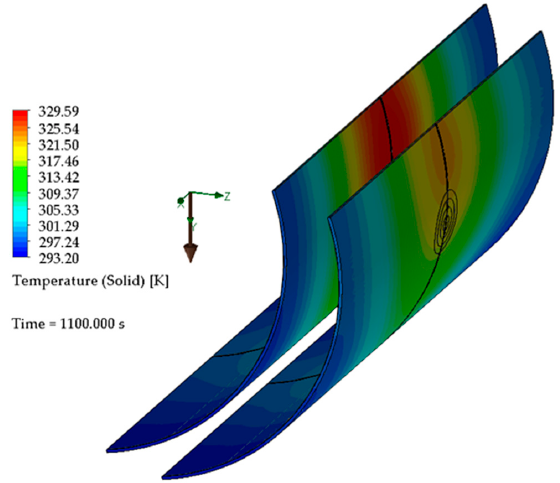
Figure 24. Temperature at 1100 s.